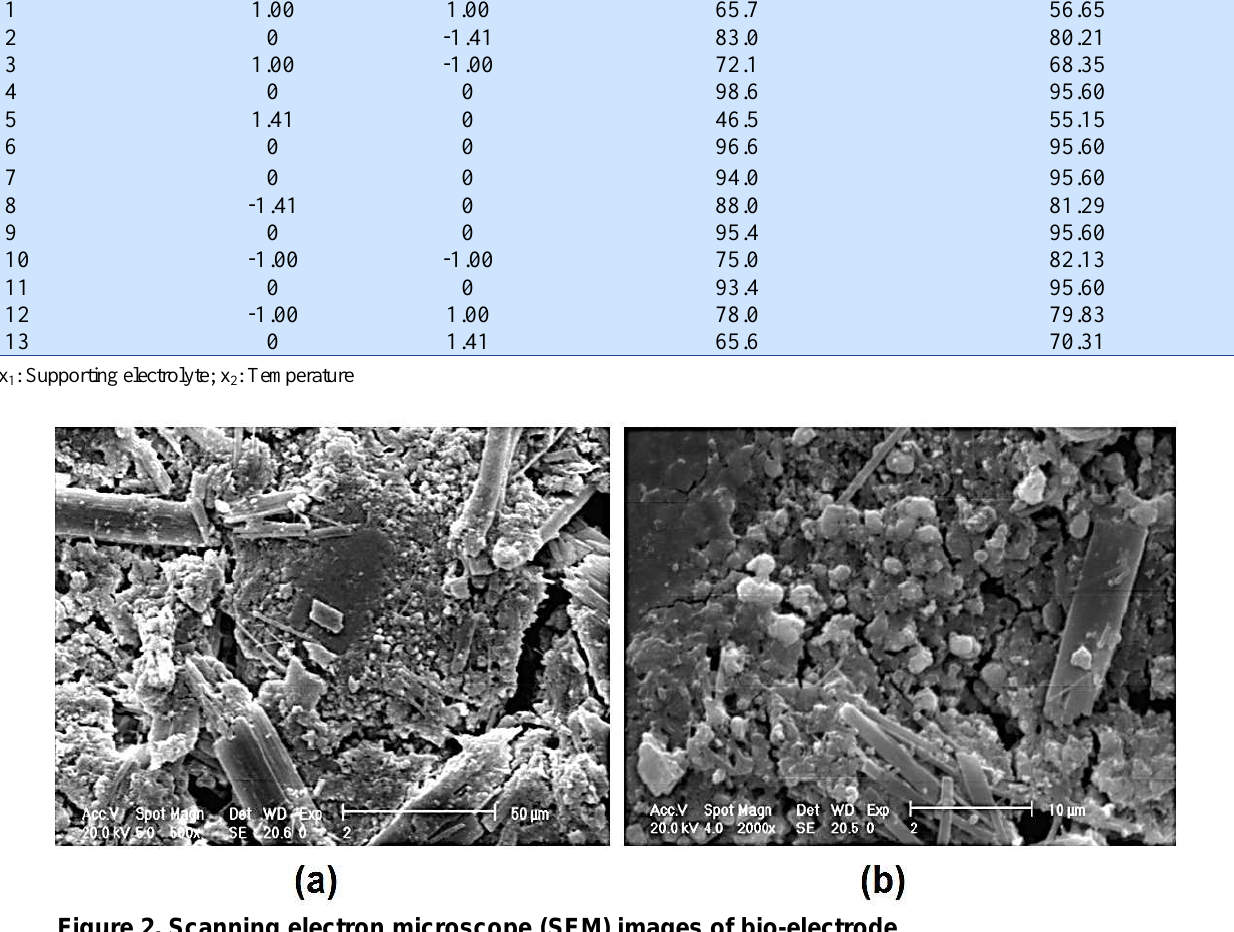
Table 2. Central composite design (CCD) consisting of 13 experiments for the study of two experimental factors in coded units along with observed values Run